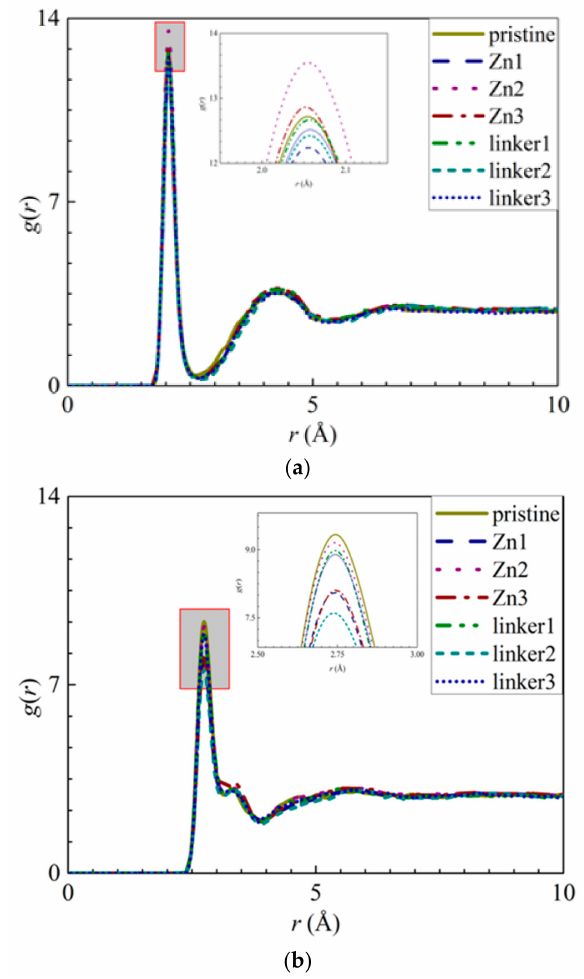
Figure 4. RDFs of the O atoms from the water molecules around the ions: ( a ) Na + ions and ( b ) Cl − ions for the respective ZIF-8